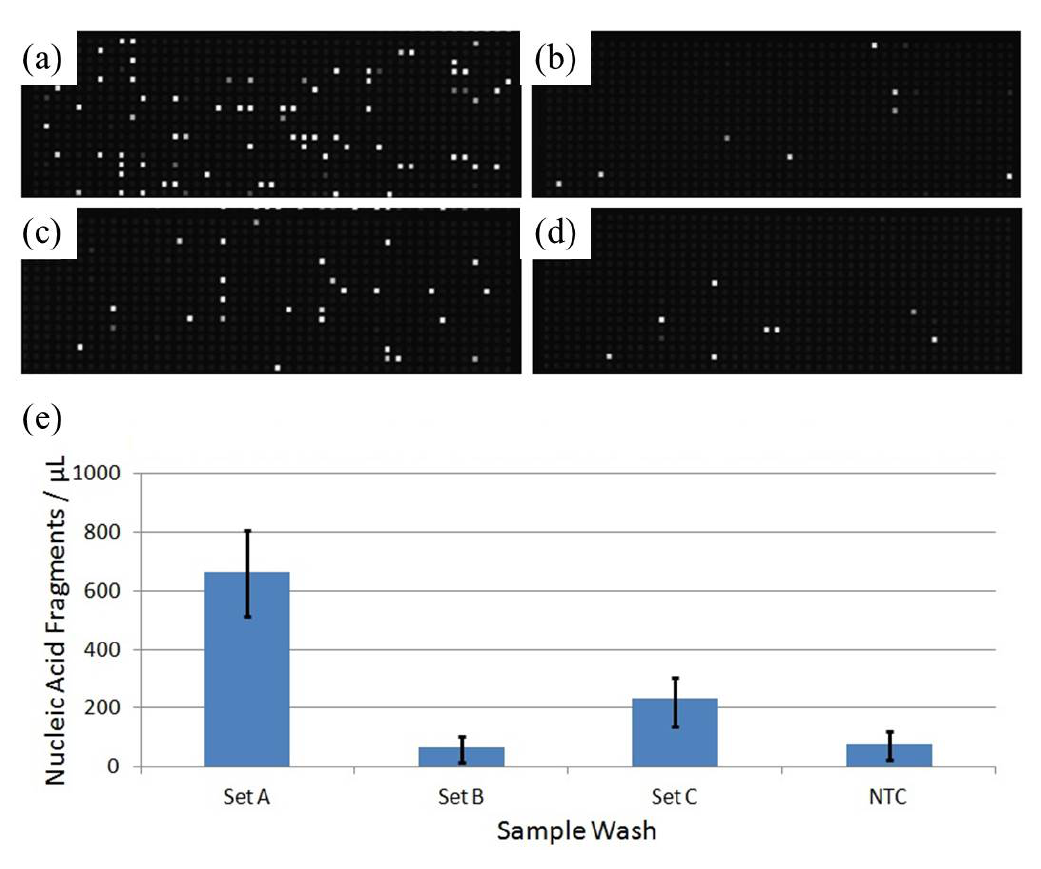
Figure 6. Nucleic acid fragment content of final sample set washes. The supernatant of the final wash for each sample set was saved and diluted by a factor of 200. Nucleic acid fragments of the supernatants were quantified to obtain an idea of the level of sample exogenous contamination present in each set injection. Panels are lettered by sample ID ( a ) through ( c ) while the fourth ( d ) is a no-template control. Target counts are quantified per microliter of wash analyte ( e ), with error bars representing upper and lower 95% confidence interval